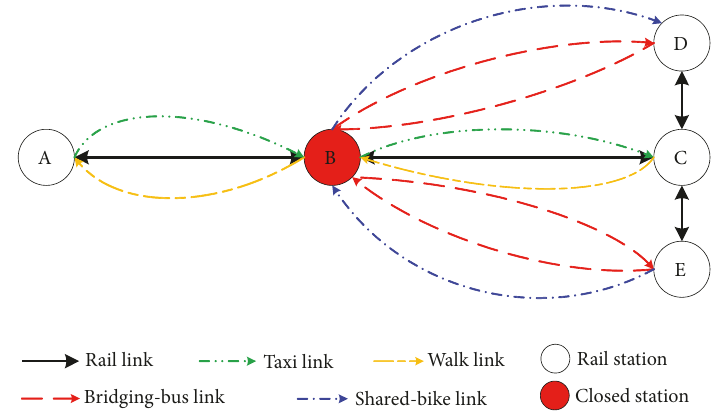
Figure 1: Illustrative example of station disruption problem in metro networks.